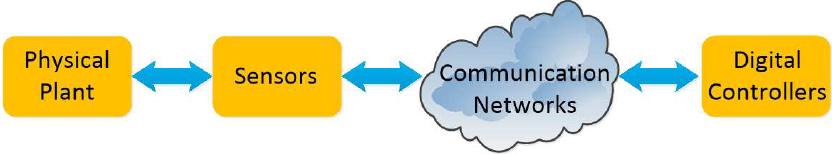
Figure 1. A simple networked control